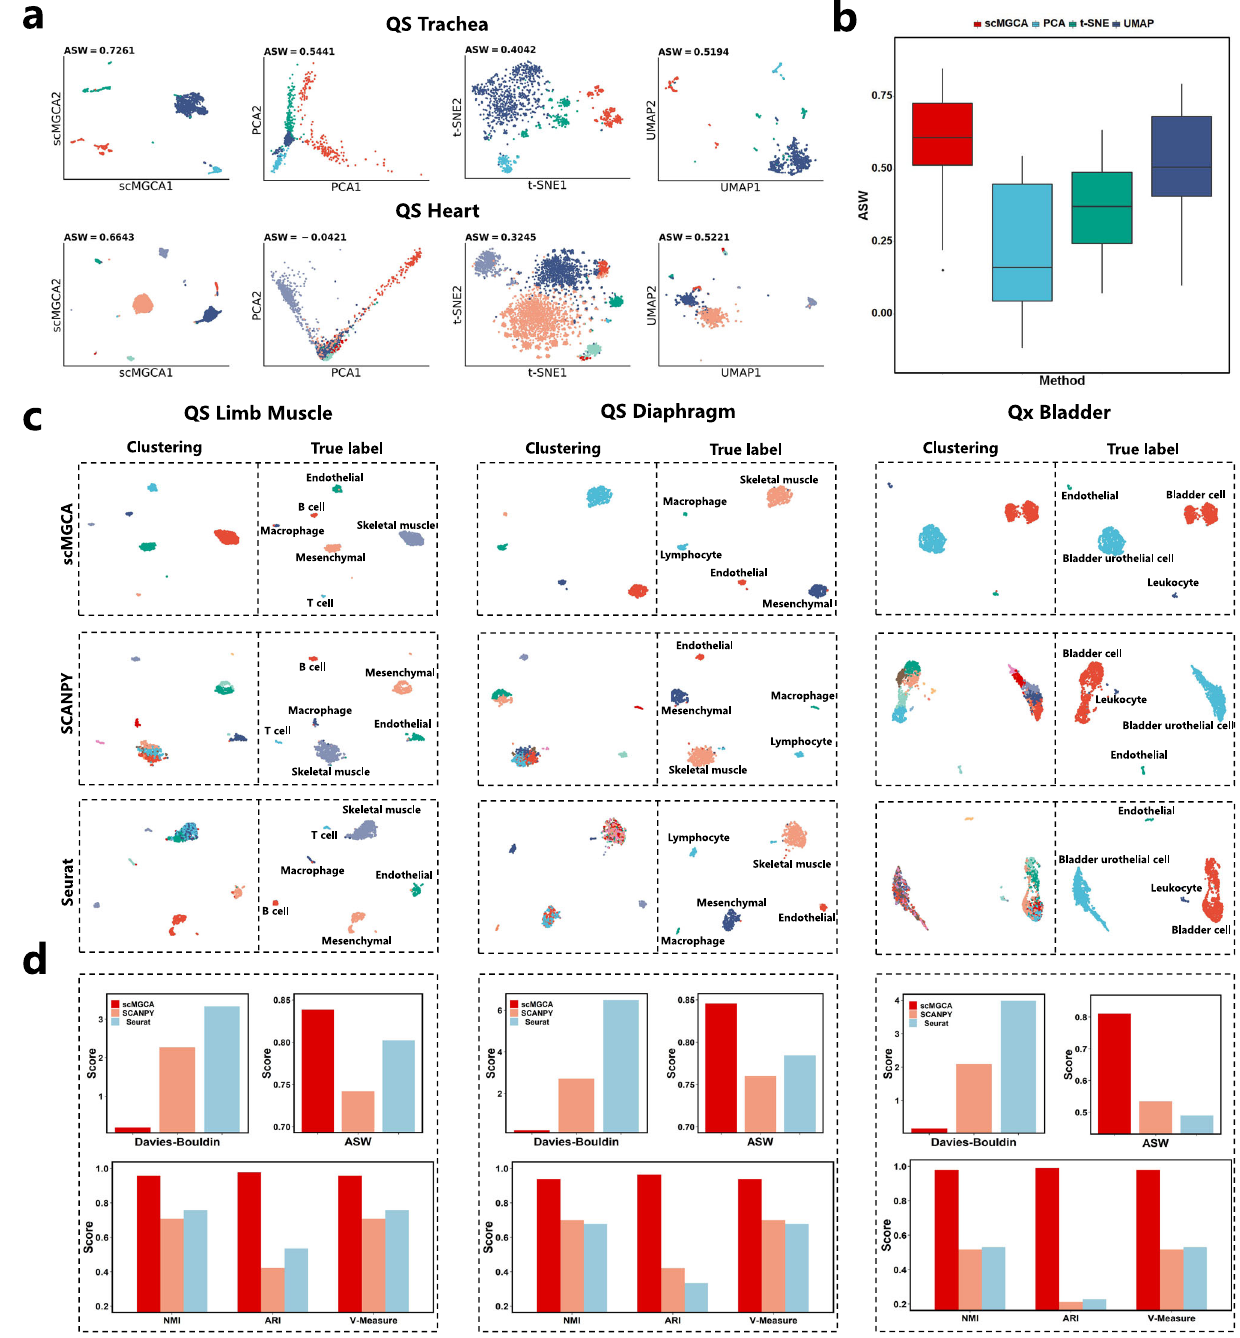
Fig. 3 | Dimensionality reduction performance and visualization capacity of scMGCA. a Visualization of scMGCA and three dimensionality reduction methods (PCA, UMAP and t-SNE) on 'QS Trachea' and 'QS Heart'. b Comparison of the ASW across 20 datasets ( n =20; center line, median; box limits, upper and lower